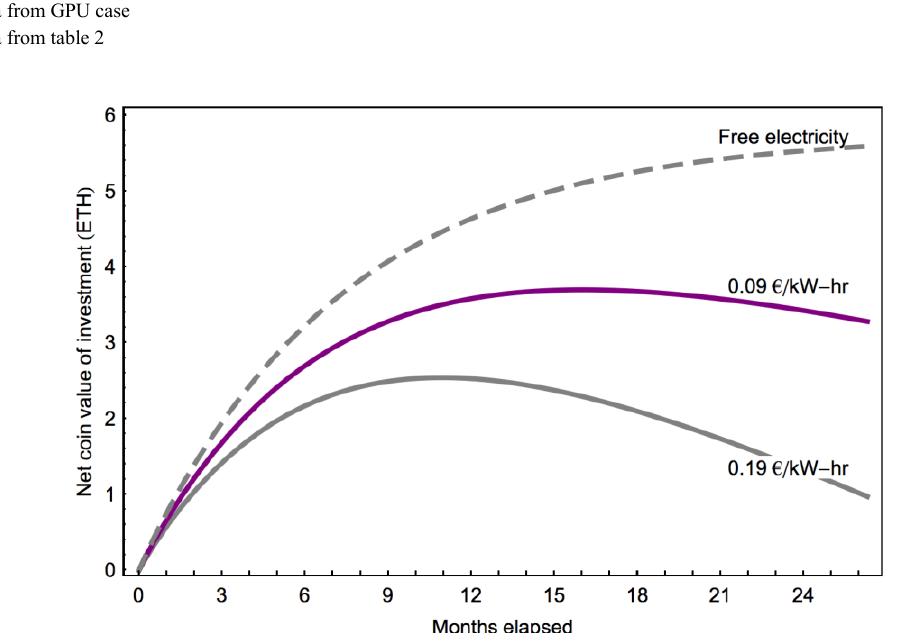
Fig. 3. Effect of different electricity prices on the Net Coin Value the miner. Doubling the electricity price from 0.09 to 0.19 does not halve the NCV